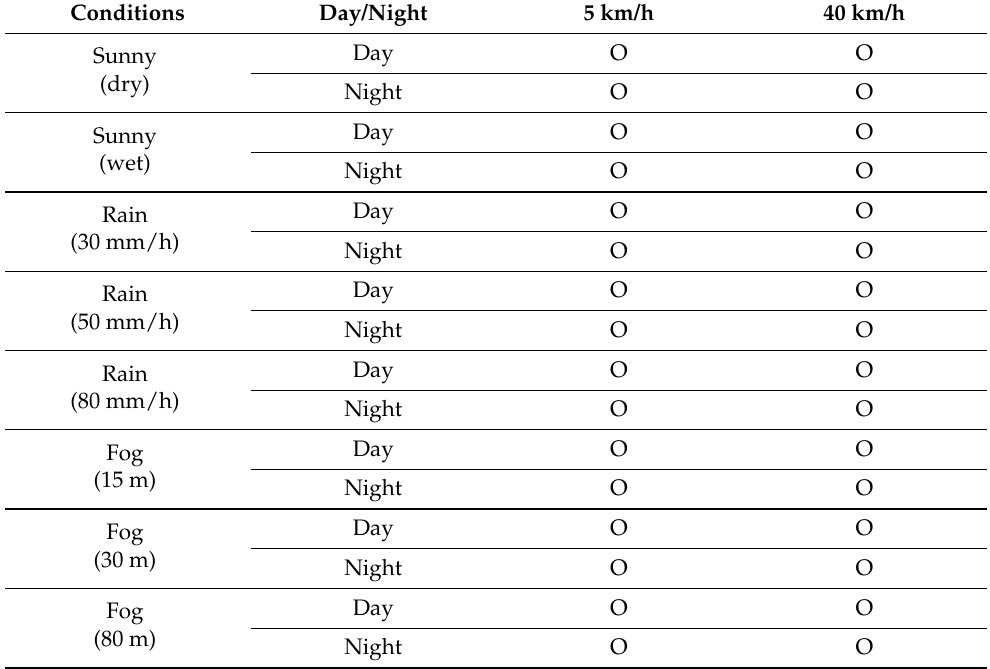
Table 1. JARI data set configuration. “O” indicates that data exist. Rain data are composed of the three settings to deal with precipitation (30 mm/h, 50 mm/h, and 80 mm/h) and fog data also contain three settings to handle the degree of fog (15 m, 30 m, and 80 m visible distance).